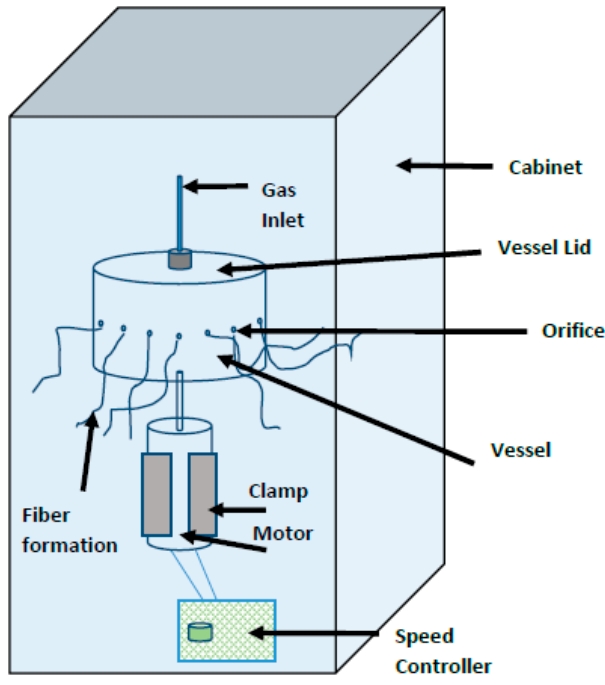
Figure 1. Experimental set-up of the pressurised gyration rig used in this work.